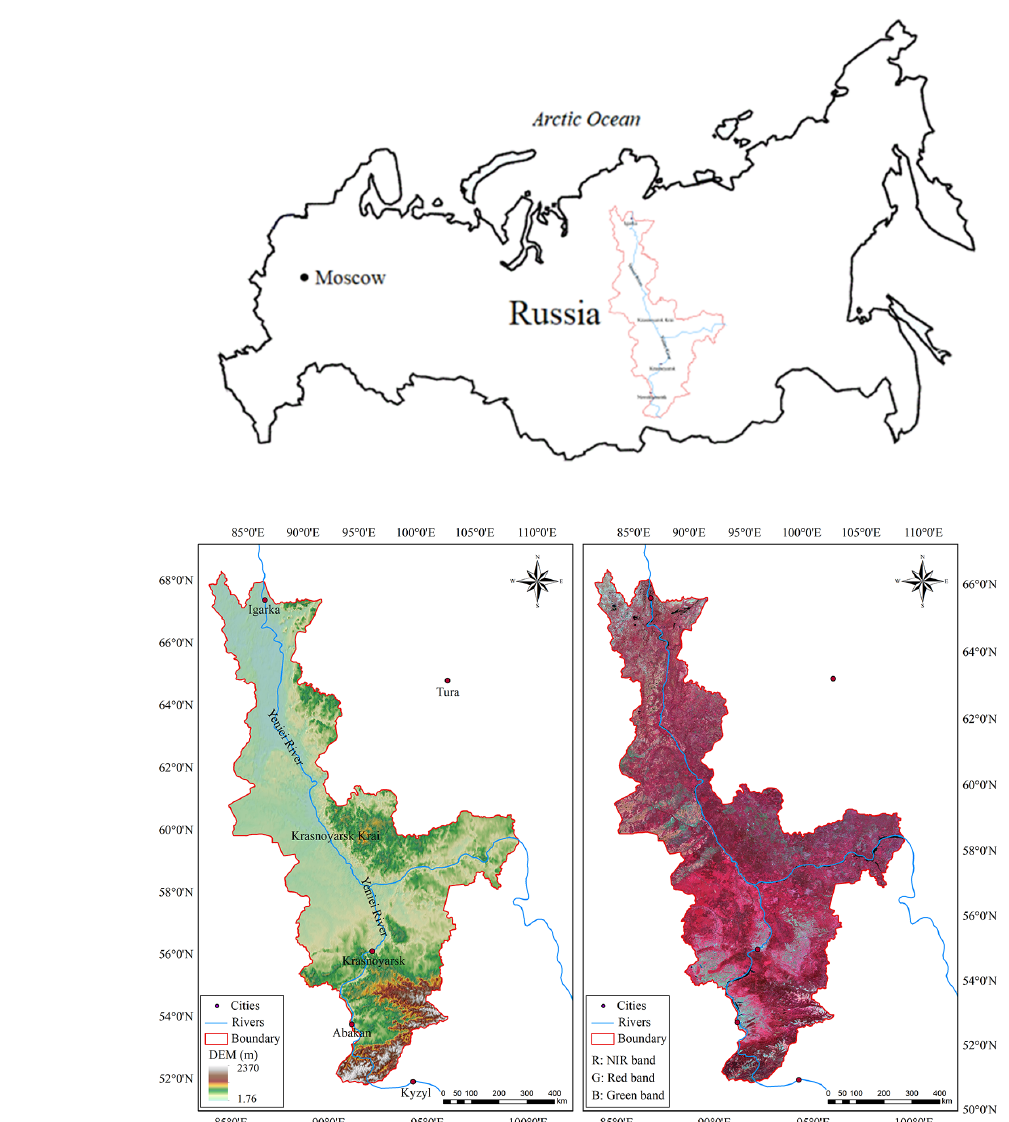
Figure 1. Location of the study area together with the DEM and false-color composite of Landsat 8